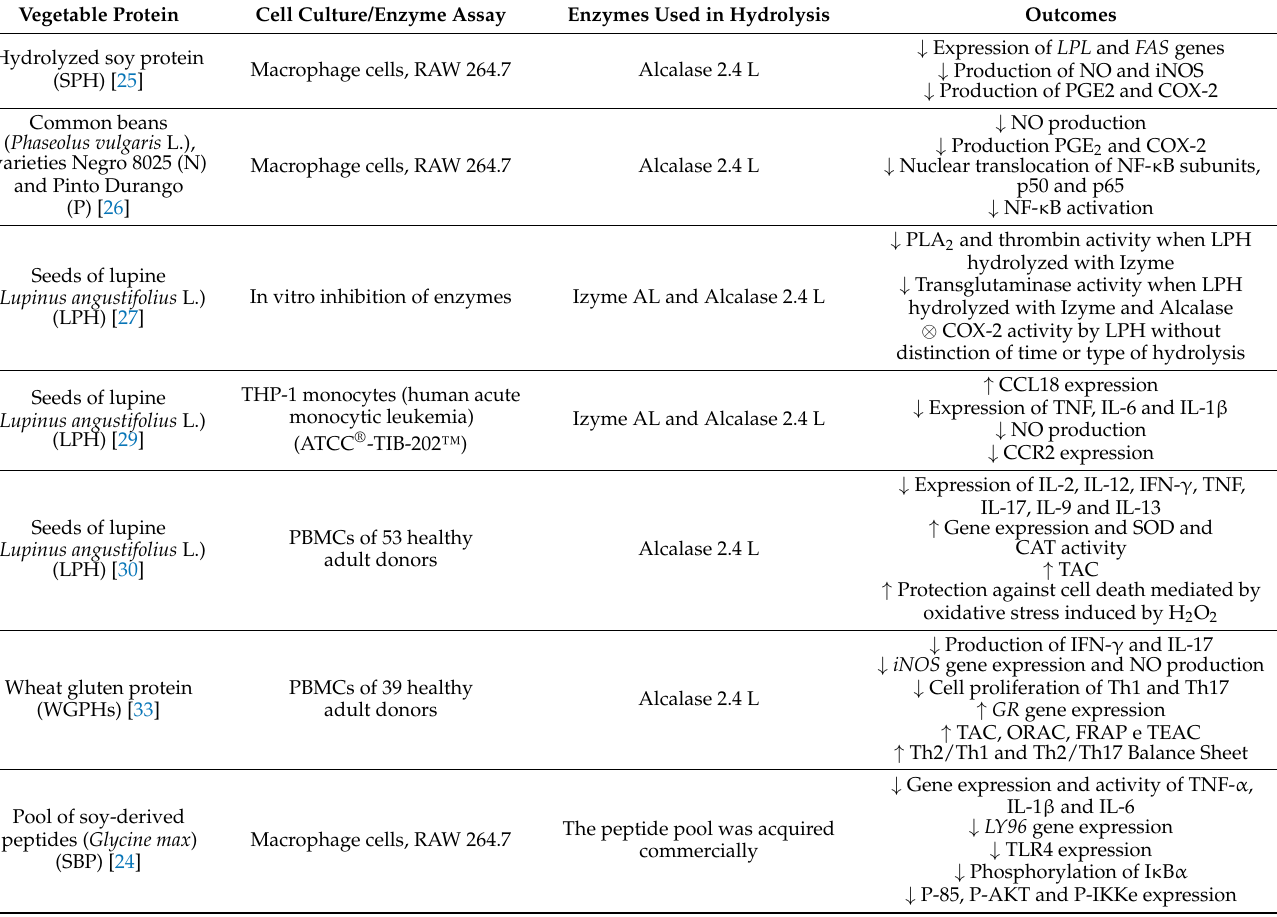
Table 1. Anti-inflammatory and immunomodulatory effects of hydrolyzed vegetable proteins re- ported in the